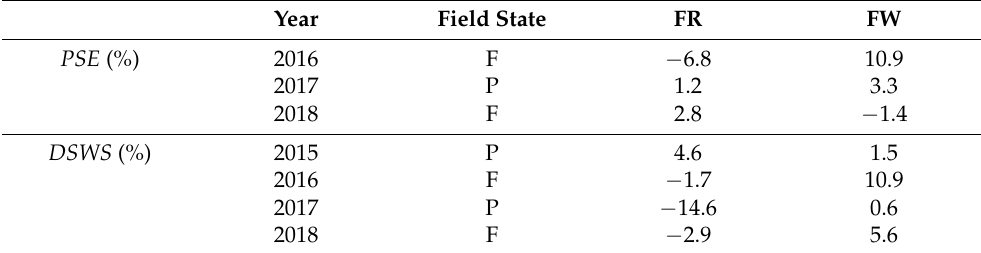
Table 4. The results of the precipitation storage efficiency ( PSE )and the difference between the soil water storage in a field after fallow period and the soil water storage in adjacent rangeland ( DSWS ). Year Field State FR FW PSE (%) 2016 F − 6.8 10.9 2017 P